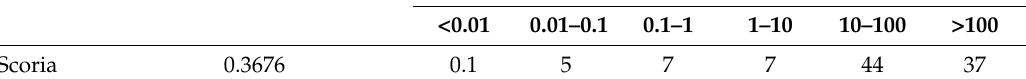
Table 2. MIP test results of scoria as lightweight aggregate.